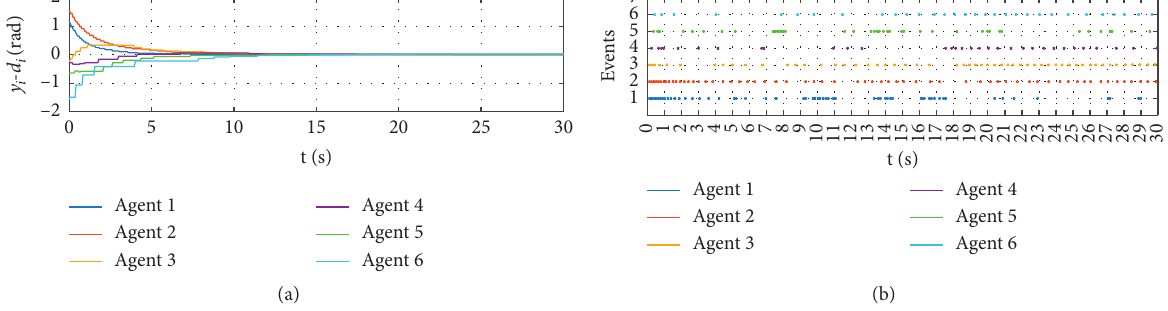
Figure 4: Simulation results of the nonuniform quantification algorithm. (a) Represents the evolution of the difference between current angular distance and the desired one between each pair of neighboring agents. (b) Represents the event sequences of N � 6 agents.